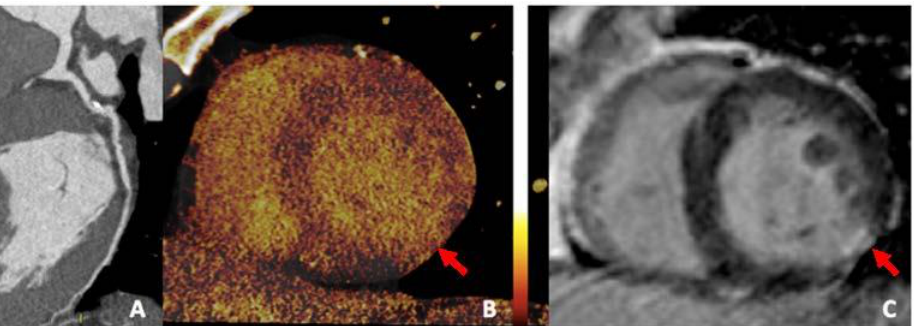
Figure 5 . Coronary dual-source DECT: ( A ) Left circumflex coronary artery shows severe proximal stenosis due to the presence of a calcified plaque. ( B ) Iodine perfusion map depicts the perfusion defect of the inferolateral wall (arrow) corresponding to a myocardial scar (arrow) in the short axis LGE MR sequence ( C ), suggestive of necrosis.